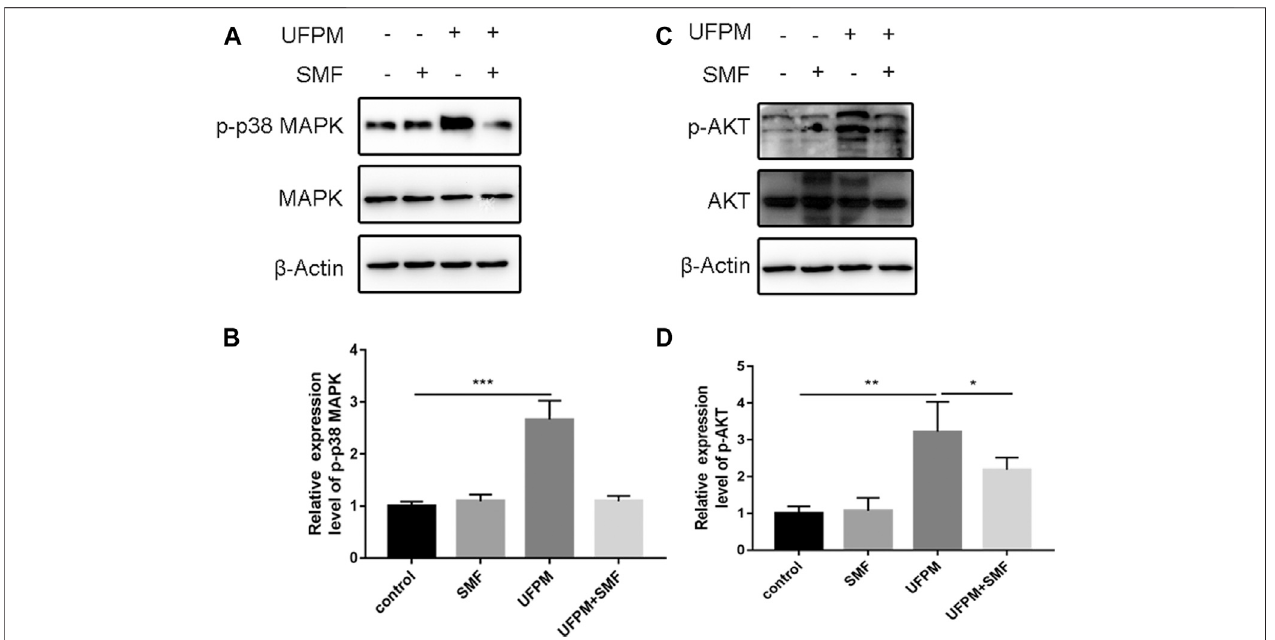
FIGURE 7 | SMF inhibits UFPM-induced p38 MAP kinase and PI3K/AKT activation. H9C2 cells pre-incubated with either medium or SMF (1.12 mg/ml) for 24 h were stimulated with UFPM (50 mg/ml) for 6 h. The lysates from H9C2 were analyzed by western blotting using speci fi c antibodies to (A) phospho-p38 MAP kinase (p-p38 MAPK) and (B) p-AKT. The cells were cultured with medium ( lane 1 ), SMF ( lane 2 ), UFPM ( lane 3 ), and UFPM and SMF ( lane 4 ). Fold increases in amounts of phosphorylated p38 MAP kinase proteins are indicated. The amounts ofp-p38MAPK and p-AKT were quanti fi ed using NIH Image Analyzer and are shown as the amounts relative to control cells. Three identical experiments were independently performed providing similar